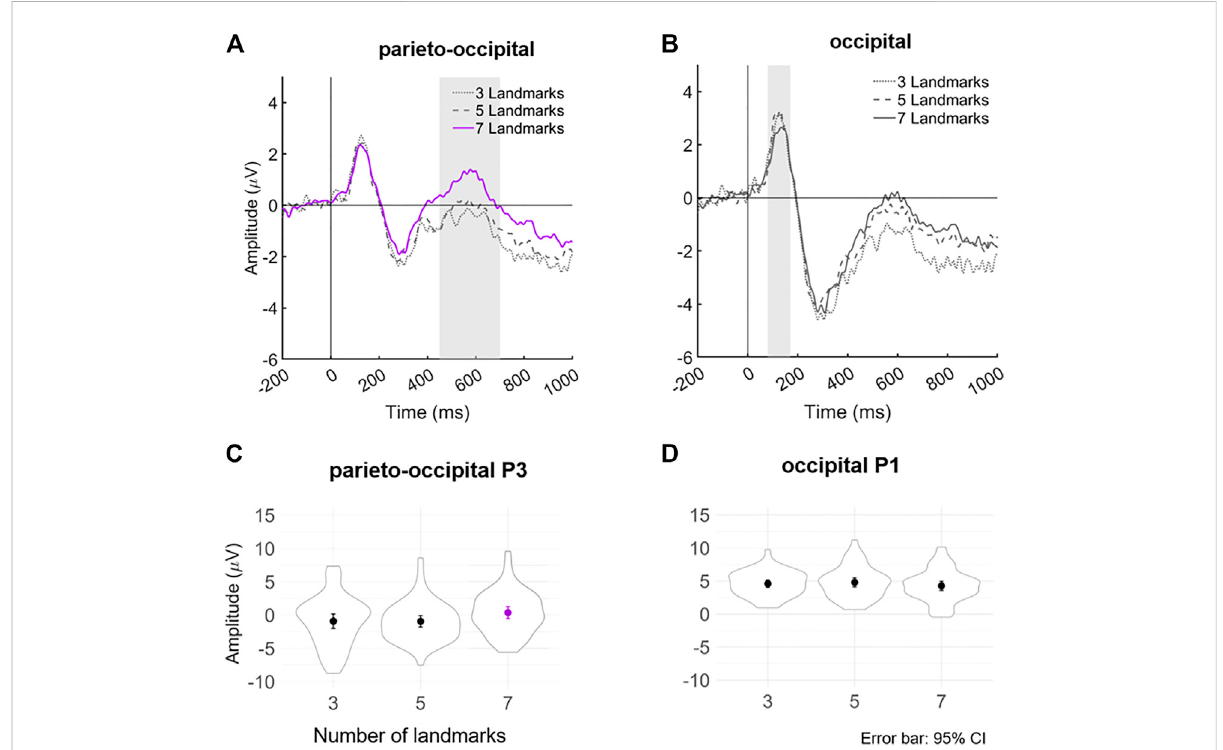
FIGURE 7 (A,B) GrandaveragedamplitudesofERPsforeachlandmarkconditionat (A) parieto-occipitalleads(PO3,POz,PO4),and (B) occipitalleads(O1, Oz, O2). The ERP signals served as the basis for individual peak detection — areas shaded in gray indicate the time window where (A) the P3 (450 – 700 ms), and (B) P1 (80 – 150 ms) were extracted for each participant. (C,D) Violin plots display the distribution of detected peak amplitudes together with mean and ±1.96 standard error (i.e., 95% CI) in each landmark condition for (C) parieto-occipital P3, and (B) occipital P1. The line plot in the top panel and means in the bottom panel highlighted in purple indicate signi fi cant differences at p <